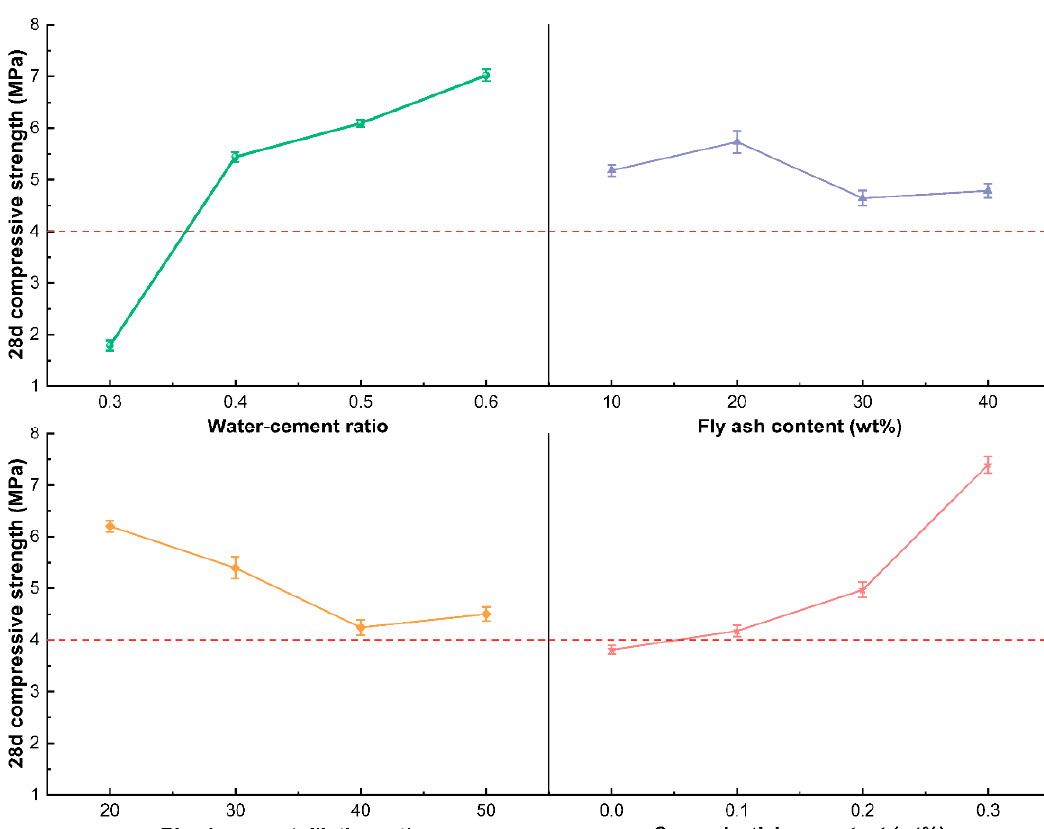
Figure 3. Effects of various factors on the compressive strength of foam concrete.